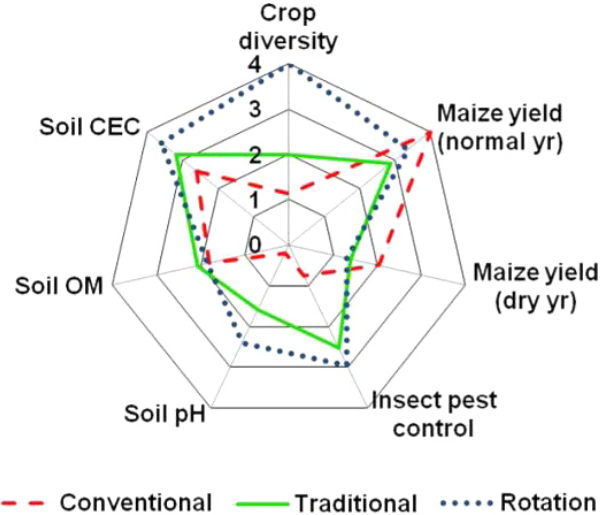
Fig. 4. Multivariate trade-offs in maize agroecosystems in the Pátzcuaro Lake watershed, Mexico. CEC = cation exchange capacity, OM = organic matter.